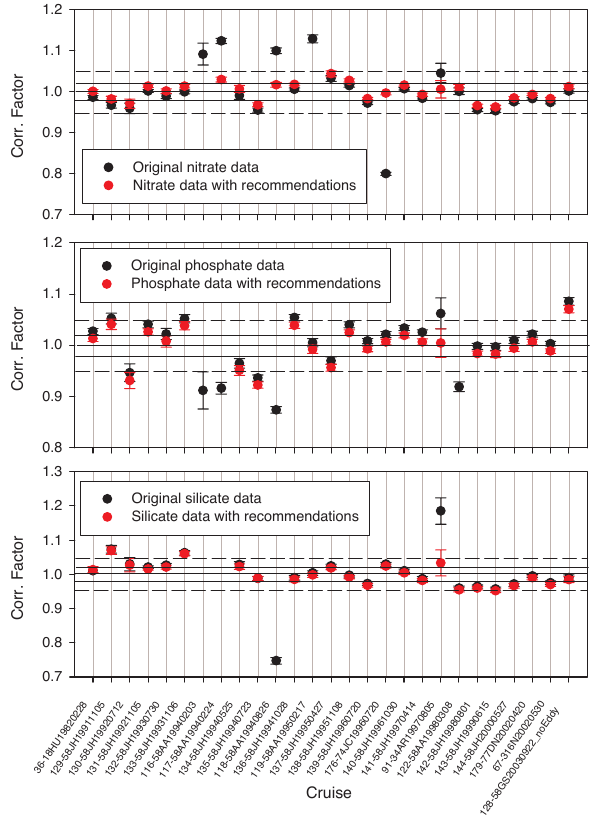
Figure 2. Results of automated crossover and inversion scripts (cna with WLSQ inversion) applied on all cruises in the collection. Dashed lines show 5% limits. Note that the cruises have been sorted by time in this figure. 58GS20030922 (128) had several stations in a submesoscale coherent eddy (Kasajima et al., 2006) , the “noEddy” signifies that these data were removed prior to this